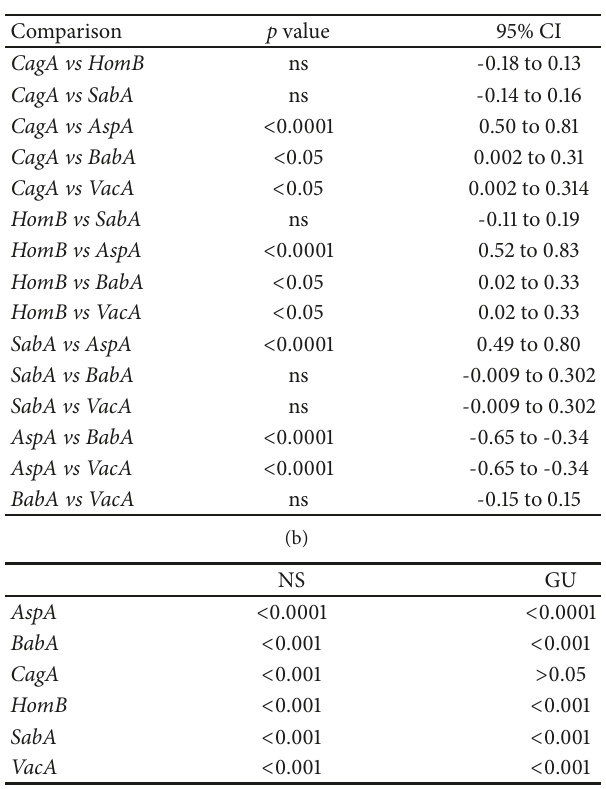
Table 2: Comparison and statistical analysis of H. pylori virulence